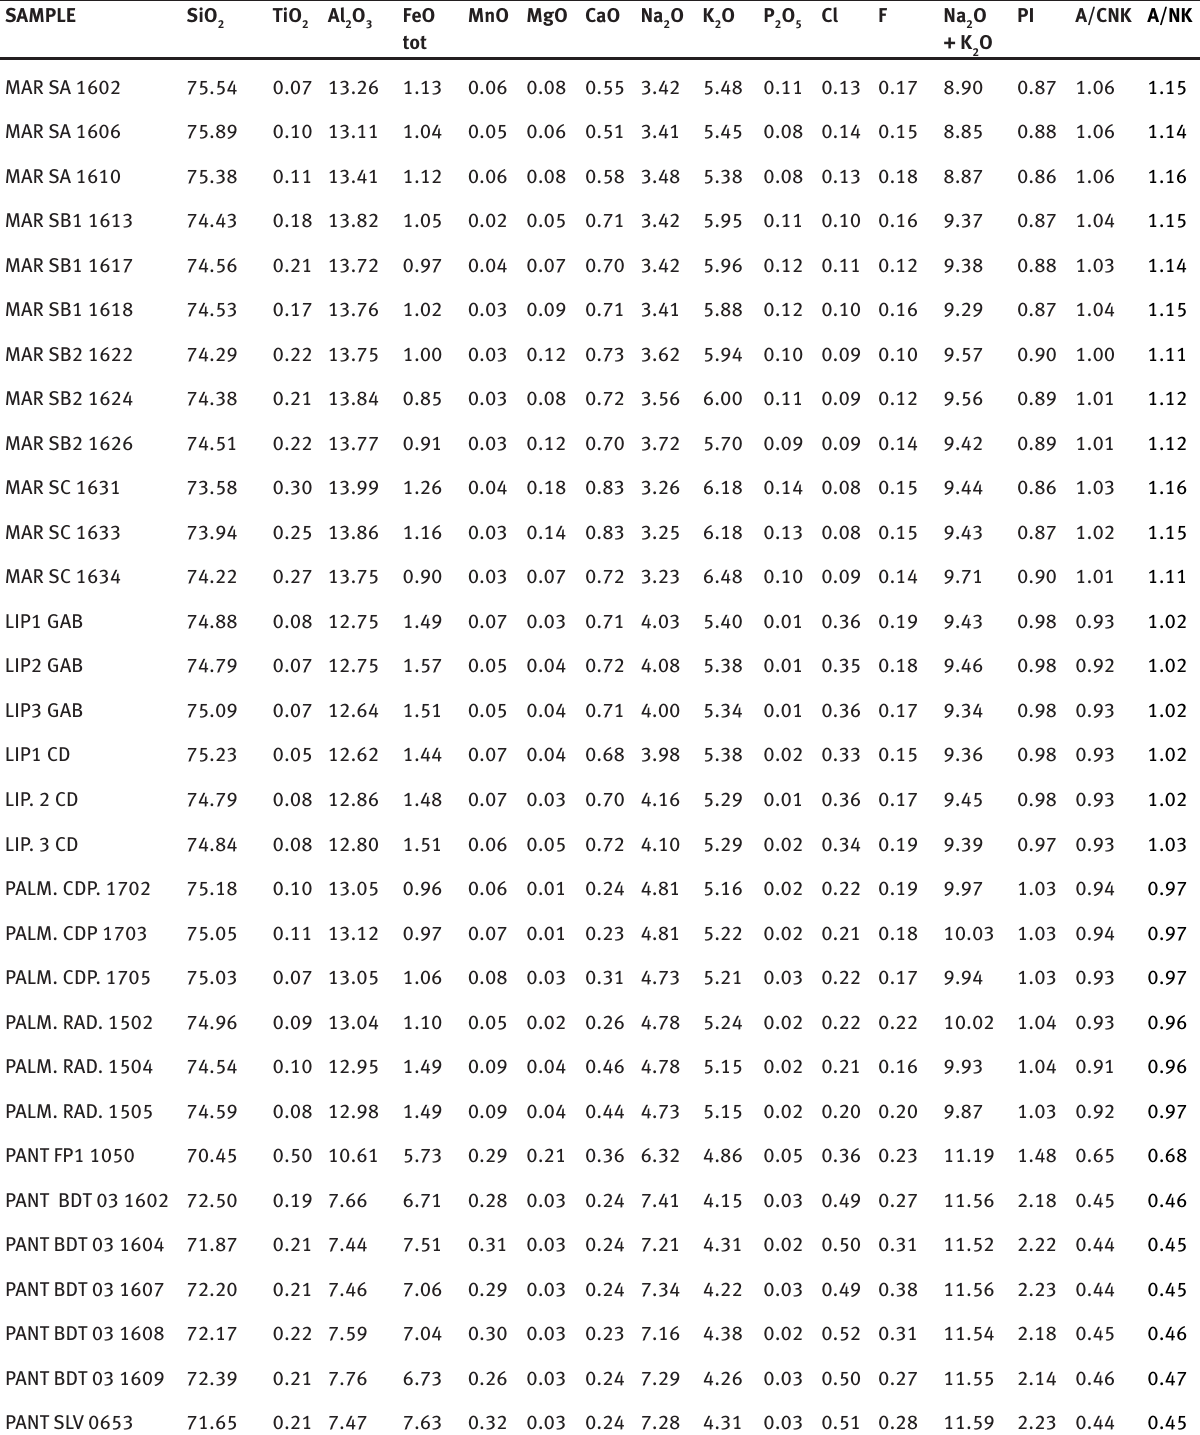
Table 3: Major and minor element wt % content of geological samples analyzed in this study. PI = peralkalinity index; A/CNK = alumina satu- ration index; A/NK = Shand (1927) index. Sample abbreviation as in Table